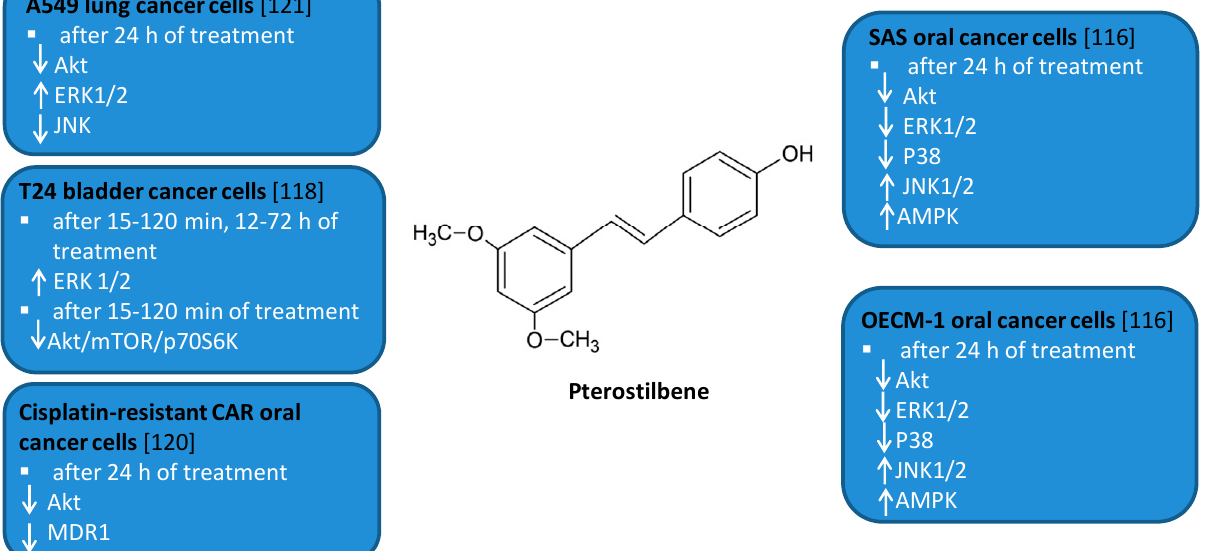
Figure 6. Cell signaling pathways triggered by pterostilbene in selected cancer cell lines. ↑ activation/upregulation; ↓ inhi- bition/downregulation.